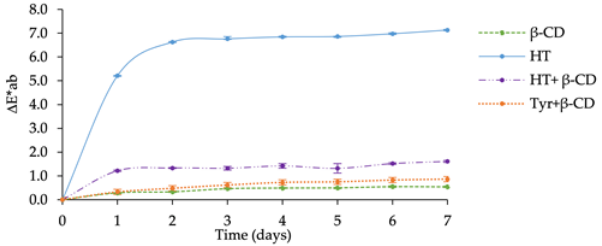
Figure 3. ∆ E*ab values of β -CD, HT, Tyr, HT+ β -CD, Tyr+ β -CD during photochemical degradation.